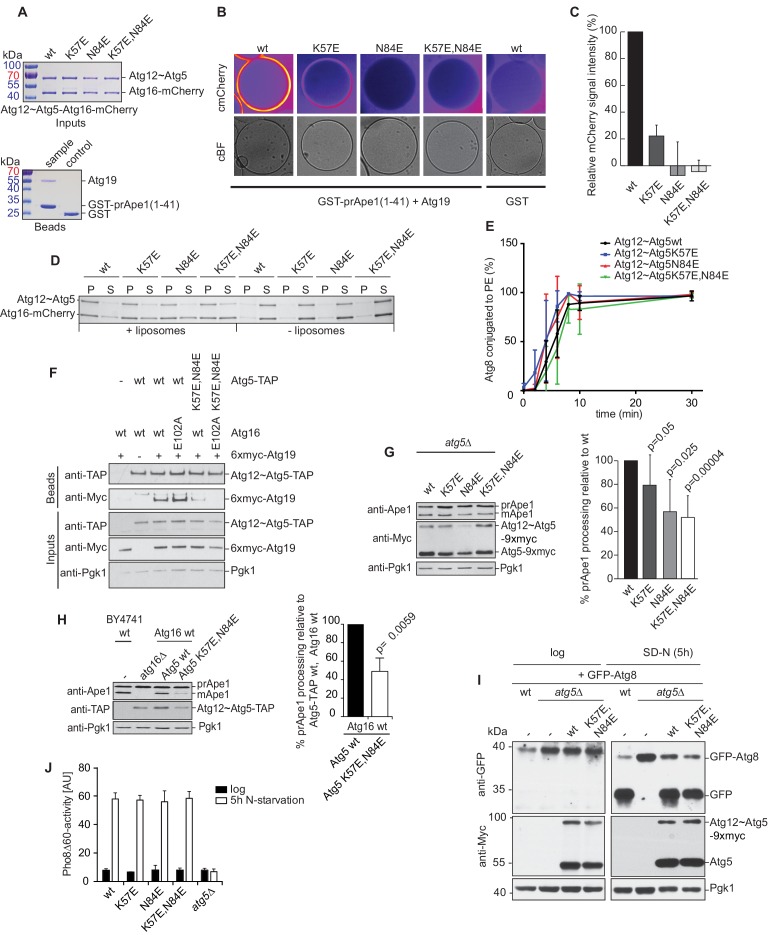
Mutation of the predicted binding sites for Atg19 in Atg5 impairs the recruitment of the Atg12~Atg5-Atg16 complex to cargo mimetic beads and Cvt pathway function but does not affect bulk autophagy.(A) Coomassie stained gels showing the input amounts of the Atg12~Atg5-Atg16-mCherry complex (upper gel) and of the GST-prApe1(1–41) + Atg19 or GST proteins on the beads (lower gel) used for the experiment shown in (B). (B) GST-prApe1(1–41) + Atg19 or GST coated glutathione beads imaged in the presence of Atg12~Atg5-Atg16-mCherry complex (wild type, K57E, N84E or K57E,N84E). (C) Quantification of three independent experiments of the relative mCherry signal intensity measured at the beads. One experiment used for the quantification is shown in (B). The signal measured for the wild type Atg5~Atg12-Atg16-mCherry complex was set to 100%. Due to optical reasons very low signals at the beads resulted in values lower than the background and thus negative values. Error bars represent standard deviations. (D) Coomassie-stained gel showing the result of a liposome co-sedimentation assay using wild type Atg12~Atg5-Atg16-mCherry and the indicated point mutants thereof. Liposome binding allows the protein to be pelleted (P). The unbound protein remains in the supernatant (S). (E) Quantification of in vitro Atg8 conjugation assays using the indicated mutants of Atg12~Atg5. The amount of conjugated Atg8 and un-conjugated Atg8 was measured as the band intensity signal on a Coomassie stained gel and set as 100%. Amounts of conjugated Atg8 were determined relative to this. Averages of these values were calculated from three independent experiments and the final values are plotted together with standard deviations. See also Figure 5—figure supplement 1. (F) Co-immunoprecipitation using Atg5-TAP or Atg5 K57E,N84E-TAP as bait in the presence of 6xmyc-Atg19 and either Atg16 wild type or Atg16 E102A. 6xmyc-Atg19 pulled down protein in wild type Atg5 and Atg16 expressing samples was set to 100. All the other conditions were quantified in relation to this (Atg5 wild type and Atg16 E102A, 85% (±59) p-value = 0.63, n.s.; Atg5 K57E,N84E and Atg16 wild type, 13% (±12.9) p-value < 0.0001; Atg5 K57E,N84E and Atg16 E102A, 2.9% (±4.6) p-value < 0.0001). The p-values were calculated using a two-tailed Student t-test. Proteins were detected using anti-TAP and anti-Myc antibodies, anti-Pgk1 was used as loading control. Shown is a representative blot of three experiments. (G) prApe1 processing assay using an atg5Δ strain transformed with the indicated expression constructs. The lower Ape1 band indicates prApe1 processing and thus its delivery into the vacuole. The prApe1 and Ape1 bands were detected with an anti-Ape1 antibody. The expression levels of Atg5 were visualised with an anti-Myc antibody. The Pgk1 signal served as a loading control. The bar graph to the right shows a quantification of six independent experiments. The p-values were calculated using a two-tailed Student t-test. (H) prApe1 processing assay using yeast atg16Δ strain with Atg5 wild type-TAP or Atg5 K57E,N84E-TAP stably integrated in the genome and transformed with the indicated Atg16 constructs. The blot shows the prApe1 processing in the Atg5 mutants in combination with Atg16 wild type in rich conditions (the full set of tested Atg16 can be found in Figure 5—figure supplement 2). A blot showing the full set of Atg16 mutants after 6 hr nitrogen-starvation is shown in Figure 5—figure supplement 3. The Ape1 bands were detected using an anti-Ape1 antibody. The bar graph shows quantification of the prApe1 processing of four independent experiments. The p-value was calculated using a two-tailed Student t-test. (I) A representative blot of a GFP-Atg8 cleavage assay is shown. (J) Pho8∆60-activity assay under rich (black bars) and 5 hr N-starvation (white bars) growing conditions using a pho13∆, pho8∆60, atg5Δ strain transformed with the indicated Atg5 expression constructs or an empty vector. At least three independent experiments were conducted and the mean values for each conditions were plotted. The error bars represent the standard deviation.